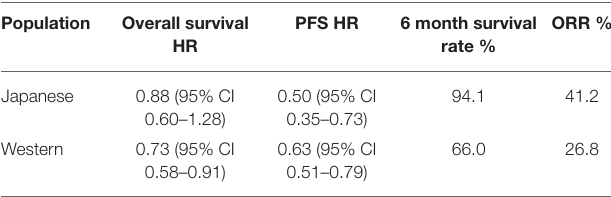
TABLE 2 | Subgroup analysis of RAINBOW efficacy data of ramucirumab in Japanese and Western patients (13).